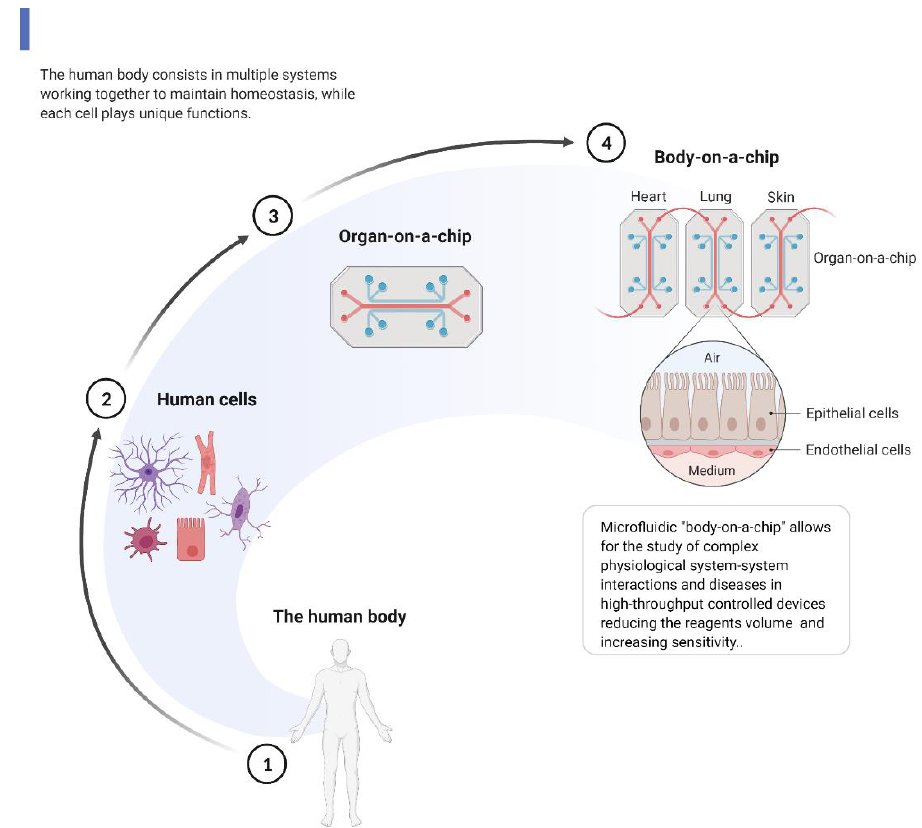
Figure 3. From human cells to a chip: schematic workflow of microfluidics technology for human cells.